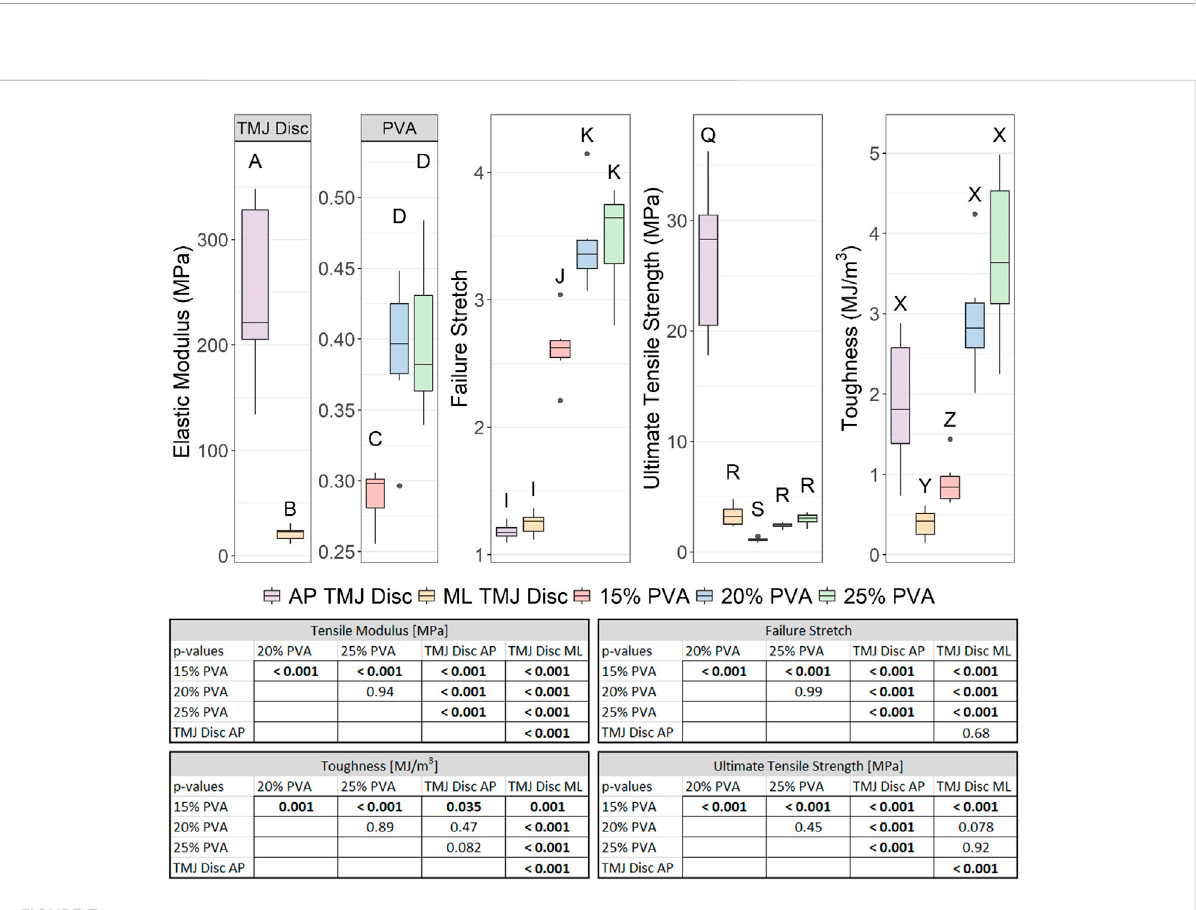
Box-and-whiskerplotsoftheaverageCOFateachspeedfromfrictionevaluationofthePVAhydrogelsandovineTMJdiscs.Groupsthatdonot share a letter were signi fi cantly different. All p – values from post hoc Wilcoxon rank - sum comparisons are provided in the associated table (right).